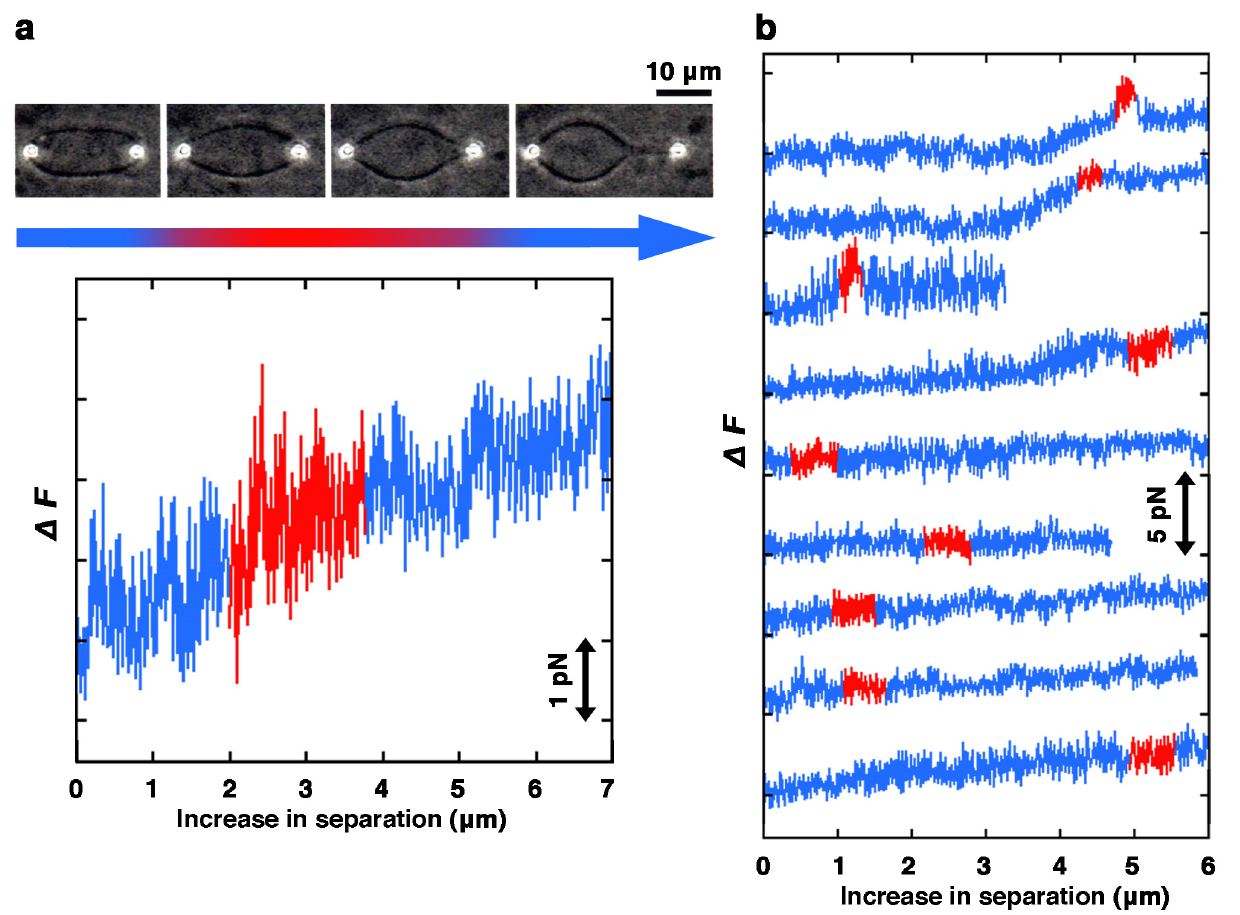
Figure 3. Measurements of liposomes prepared from DMPC. ( a ) Typical example of the process of membrane protrusion formation. Upper, sequence of phase contrast images showing a liposome being pulled. In this case, prolate or ellipsoidal liposomes were used for the measurement because spherical liposomes were difficult to prepare with DMPC. Bottom, change in the force strength required for the deformation. The color of the band below the photographs and the color of the line in the graph indicate the correspondence between images and graphs. Bar indicates 10 μ m; ( b ) Results from nine different DMPC liposomes are shown in a single graph. From the time when the long axis starts to change (drawn in blue), through when the liposome is deformed to form a projection (red), until the projection is further elongated (blue), changes in the force strength required to deform the liposome are shown. Milli-Q water was used for swelling the lipid films to prepare liposomes. Observation and measurement were carried out at 25